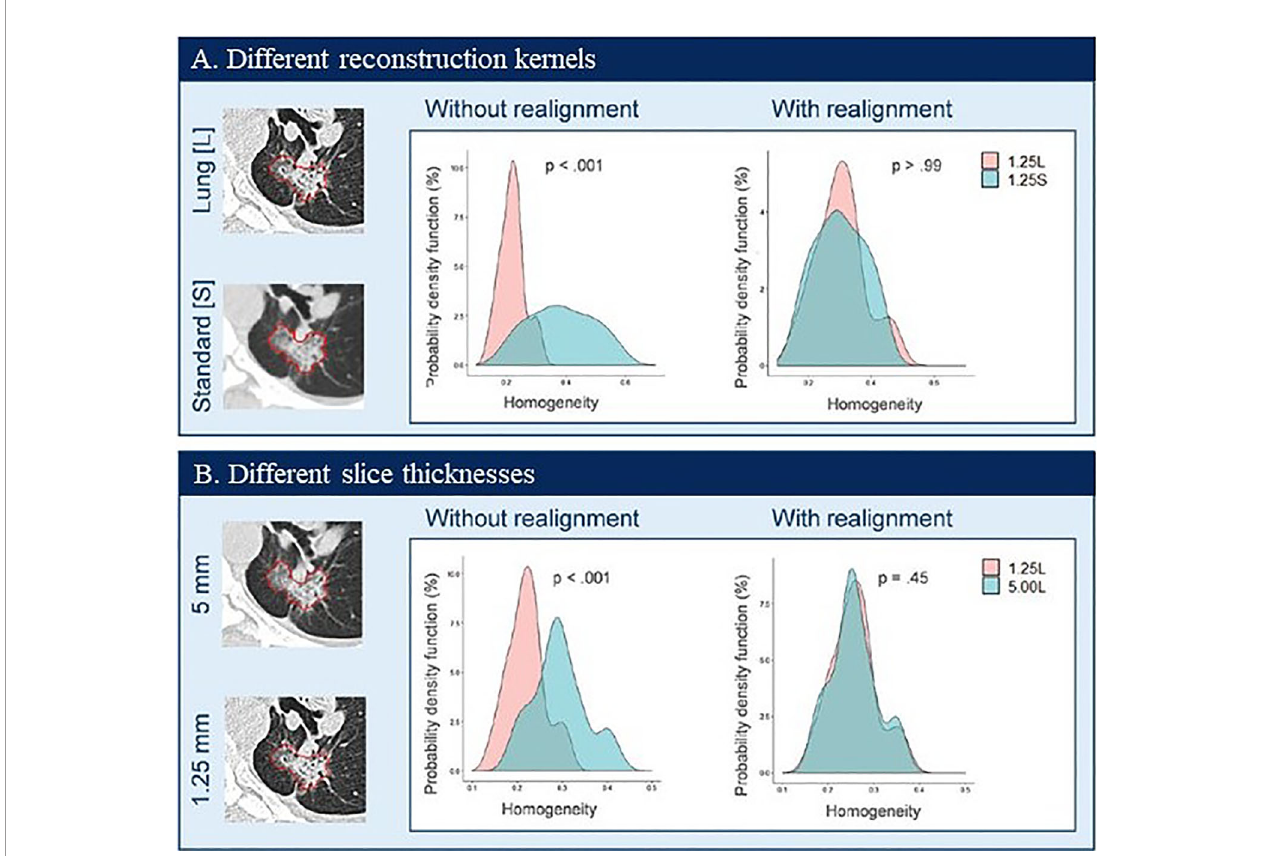
FIGURE 7 | Probability density distributions of Homogeneity before (without realignment) and after (with realignment) ComBat in patient data by using two CT reconstruction kernels (A ) and two slice thicknesses (B) . Reproduced with permission from